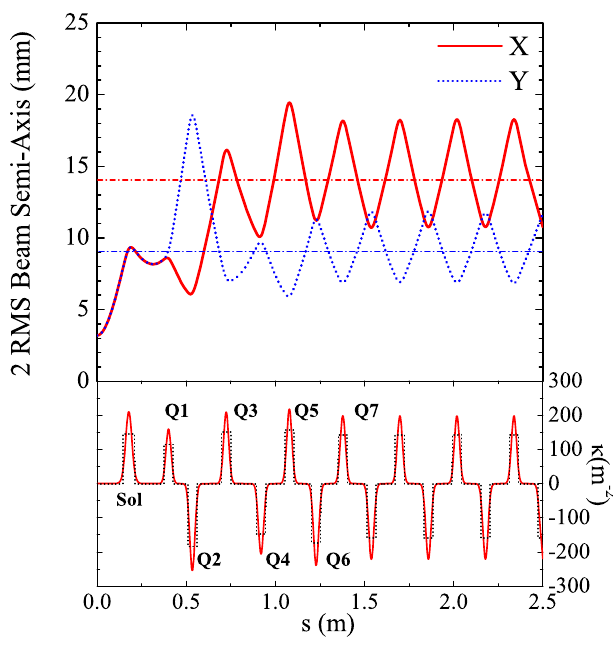
FIG. 11. (Color) UMER RMS-envelope matching with a short solenoid and seven PC quadrupoles. Electron beam parameters are: 100 mA, 10 keV, and (cid:4) (cid:5) 60 (cid:10) m . Calculated beam enve- (cid:5) 57 : 2 (cid:12) , (cid:5) (cid:5) 73 : 4 (cid:12) , highly asymmetric (from lope for (cid:5) 0 x 0 y SPOT ). One transverse component of the focusing function is shown at the bottom. The average beam radii indicated by the (cid:5) 14 : 1 mm , and a (cid:5) 9 : 0 mm horizontal broken lines are a x y (see also Fig.